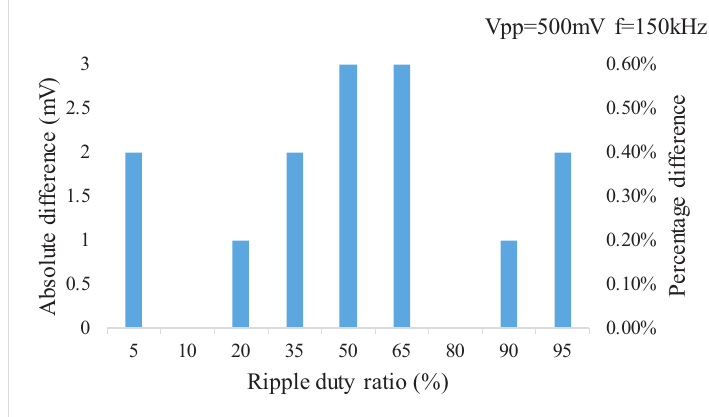
Figure 11. The measurement differences for different duty ratios.